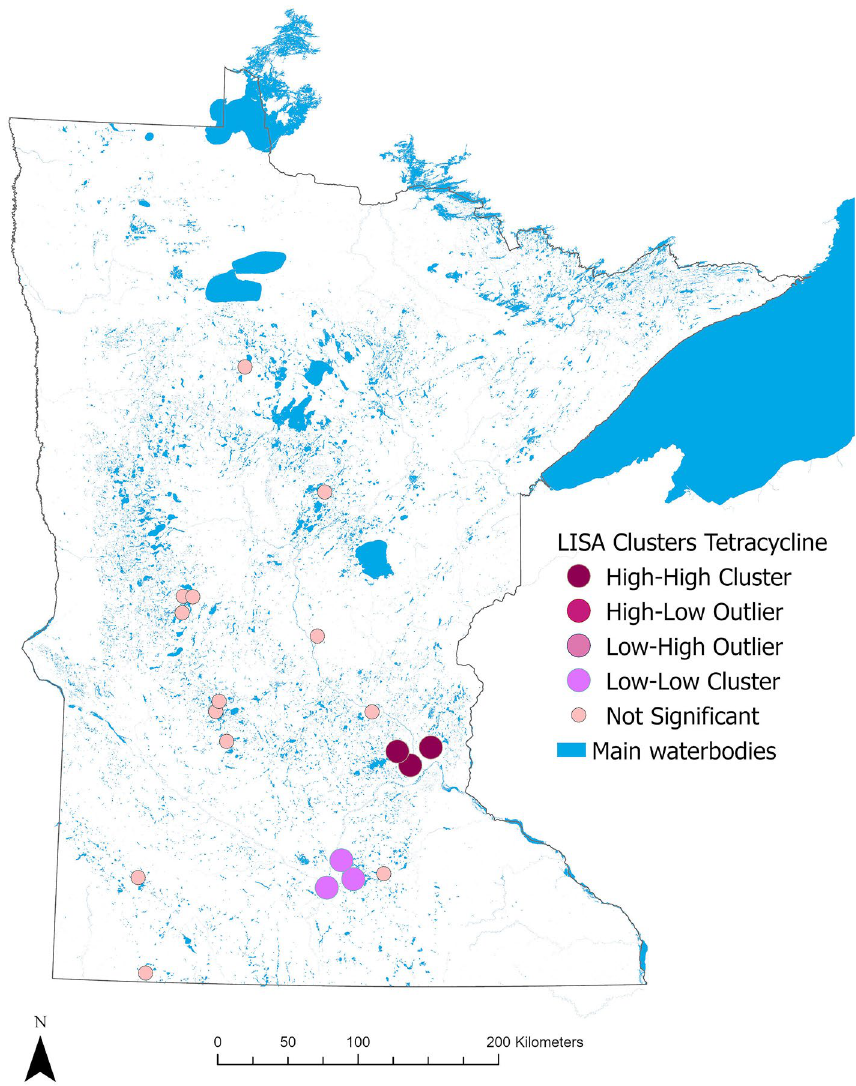
Figure 6. Results from the Anselin’s Local Morans I (LISA) test for tetracycline concentrations in water samples showing two significant clusters: one high–high, and one low–low in two